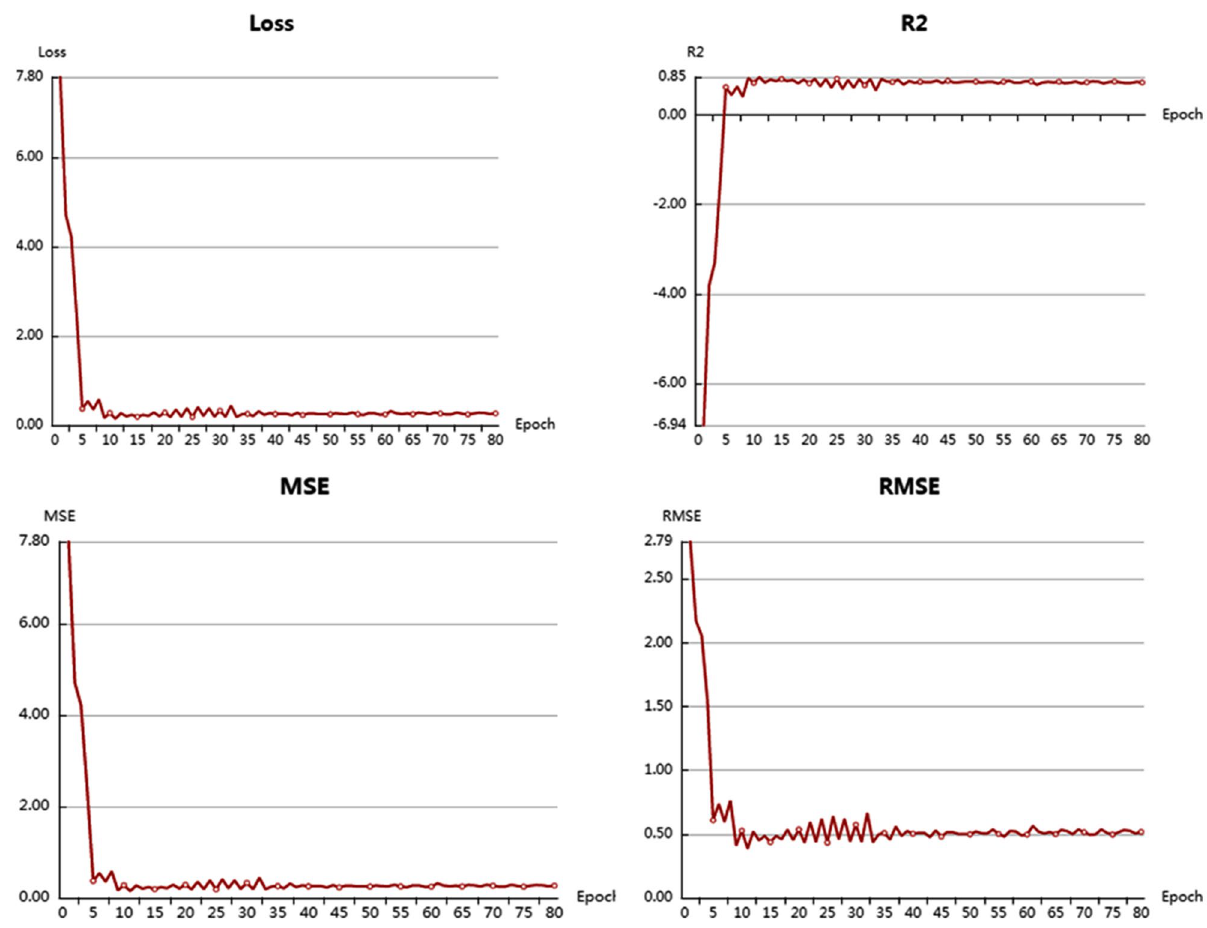
Figure 5. Statistical parameters of the deep learning screening